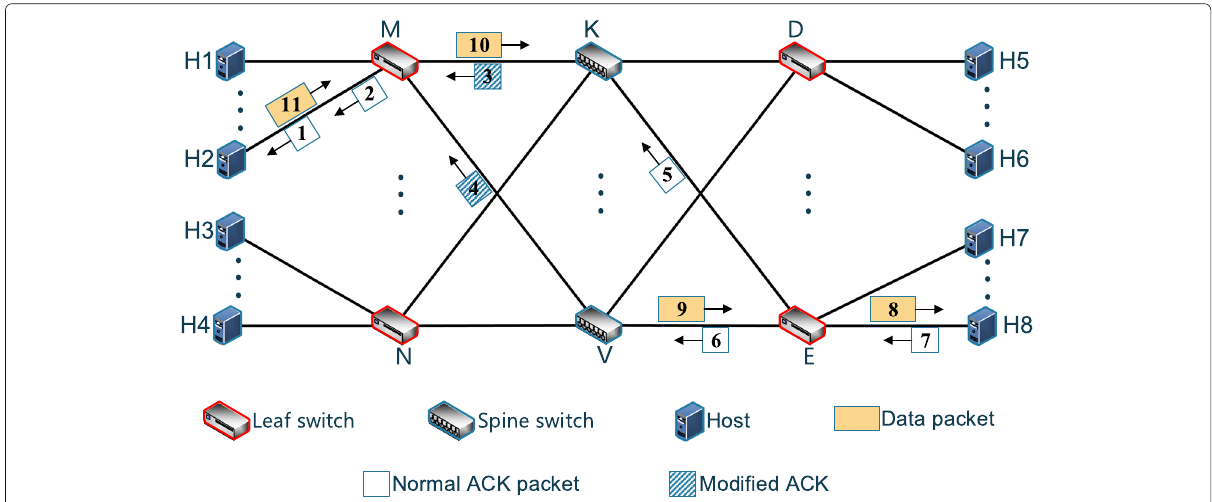
Fig. 5 Out-of-order